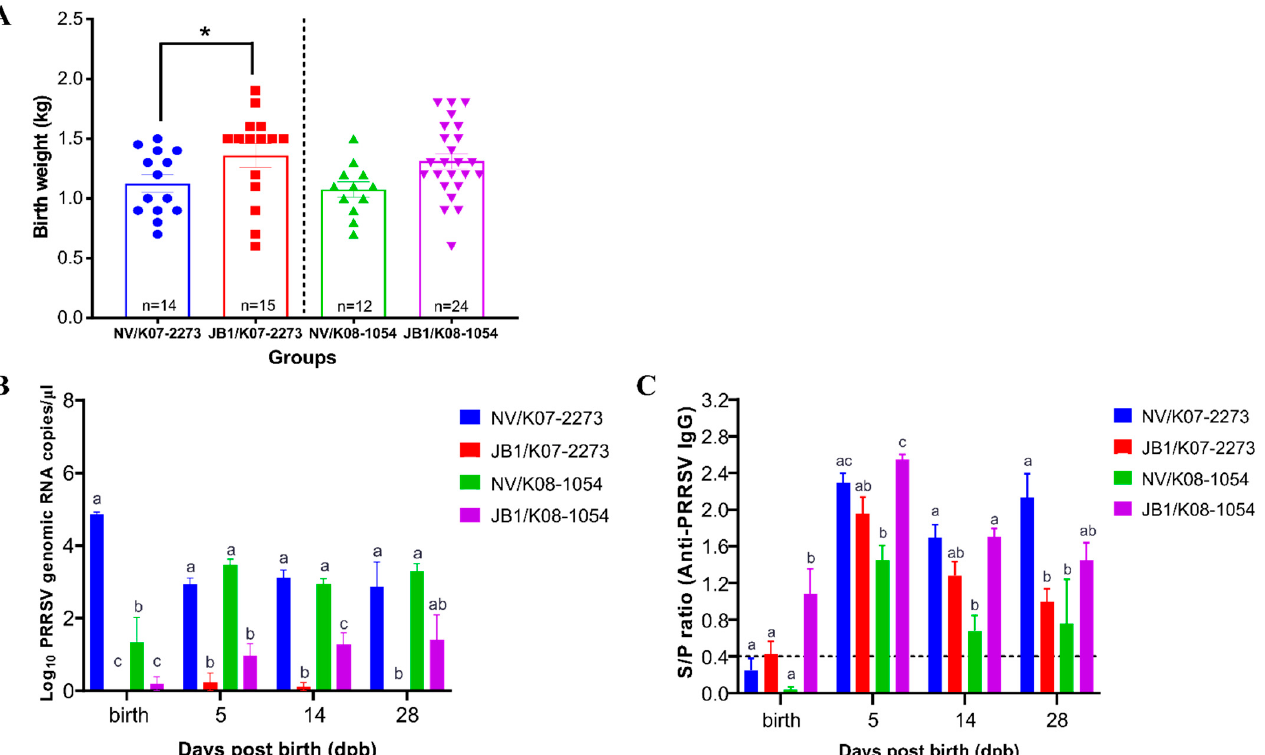
Figure 4. The birth weight of live-born piglets and results regarding the levels of PRRSV vertical transmission. ( A ) Mean birth weight values from live-born piglets of each group. Data are shown as the means ± standard error of the mean (SEM). Asterisks indicate significant differences between the NV/K07–2273 and JB1/K07–2273 groups or between the NV/K08–1054 and JB1/K08–1054 groups (* p < 0.05). ( B ) The genomic copy number of PRRSV RNA from piglets post-birth. Data are shown as the means ± SEM. Different letters represent significant differences among the experimental groups ( p ≤ 0.05, Tukey’s test, two-way ANOVA). ( C ) PRRSV-specific IgG response of piglets. Data are shown as the means ± SEM. Different letters represent significant differences among the experimental groups ( p ≤ 0.05, Tukey’s test, two-way ANOVA).